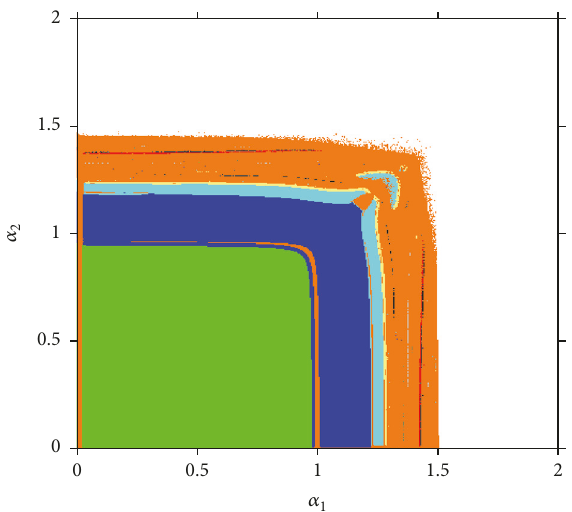
Figure 9: Parameter basins for periodic cycles with the change of 𝛼 1 and 𝛼 2 .